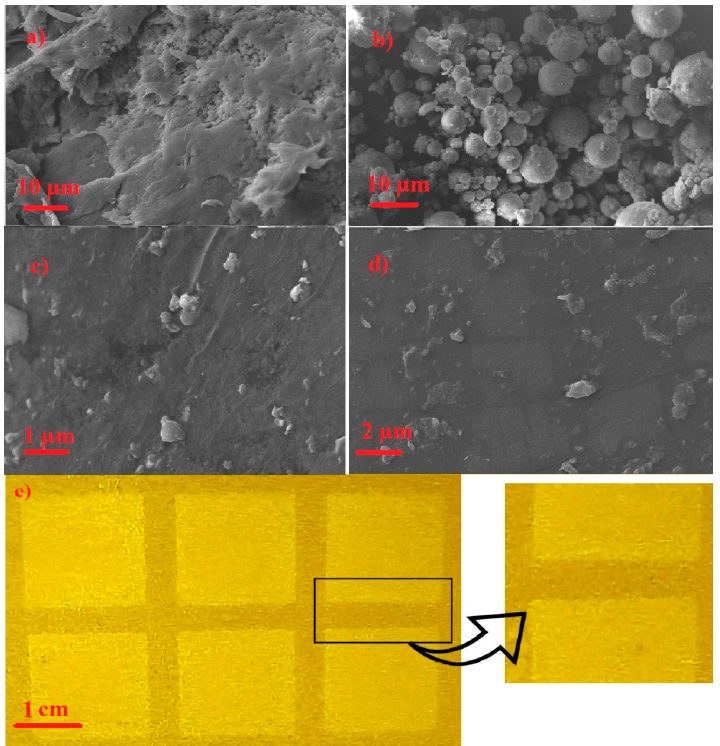
Figure 3. SEM images of ( a ) PVDF, ( b ) BaTiO 3 , ( c ) and ( d ) PVDF-BaTiO 3 (%20 ( w / w ) BaTiO 3 ) nanocomposite at different magnifications. ( e ) Image of the printed PVDF-BaTiO 3 (%20 ( w / w ) BaTiO 3 ) ff erent magnifications. ( e ) Image of the printed PVDF-BaTiO inkjet ink on a Kapton substrate. nanocomposite at di inkjet ink on a Kapton